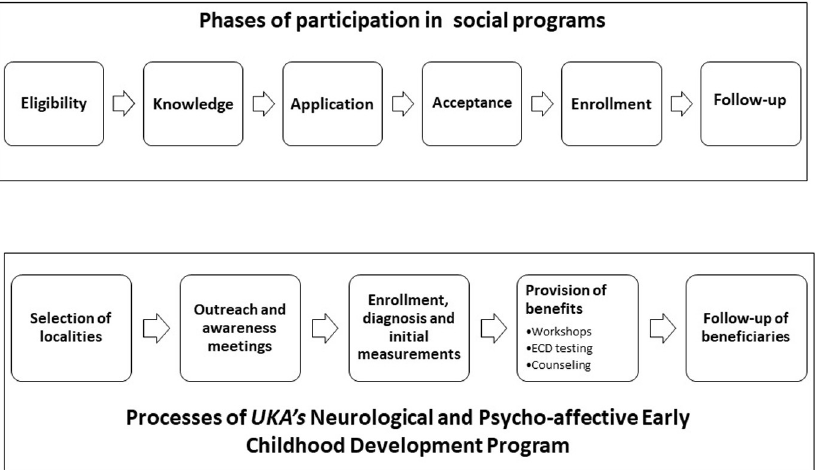
Fig 2. Phases of participation and permanence in the MIDIT . Source: Elaborated by the author based on the proposals of Heckman (2004) [9].